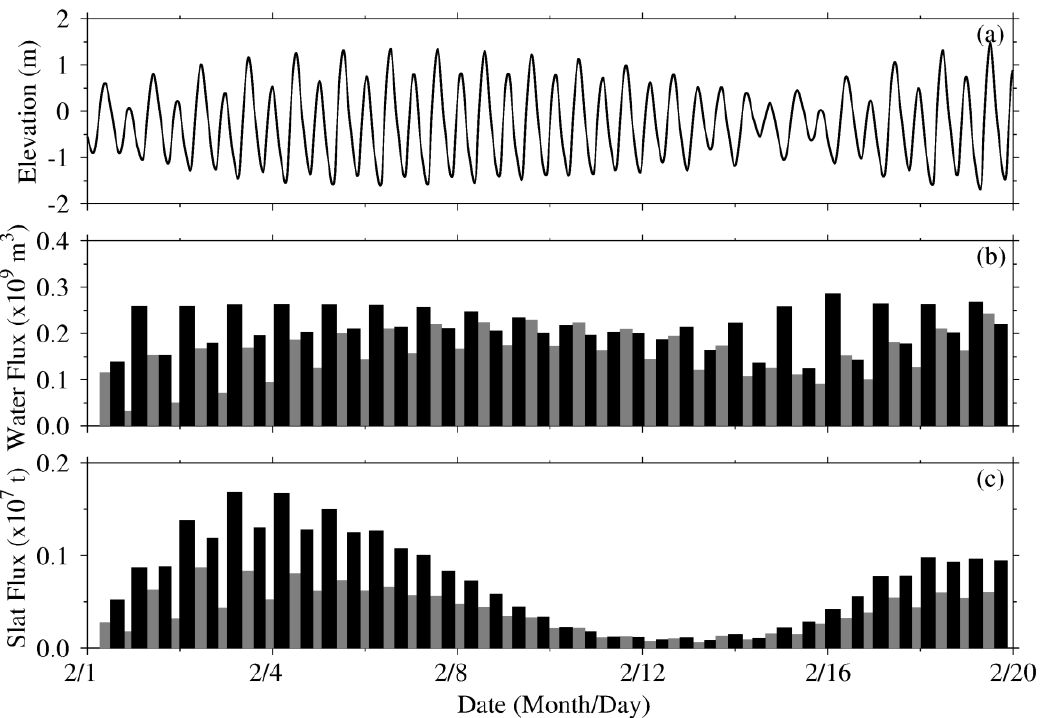
Figure 14. Temporal variations in the elevation ( a ) at site B and in the water flux ( b ) and salt flux ( c ) across Sec.1 during flood tide (gray) and ebb tide (black) in EX2.